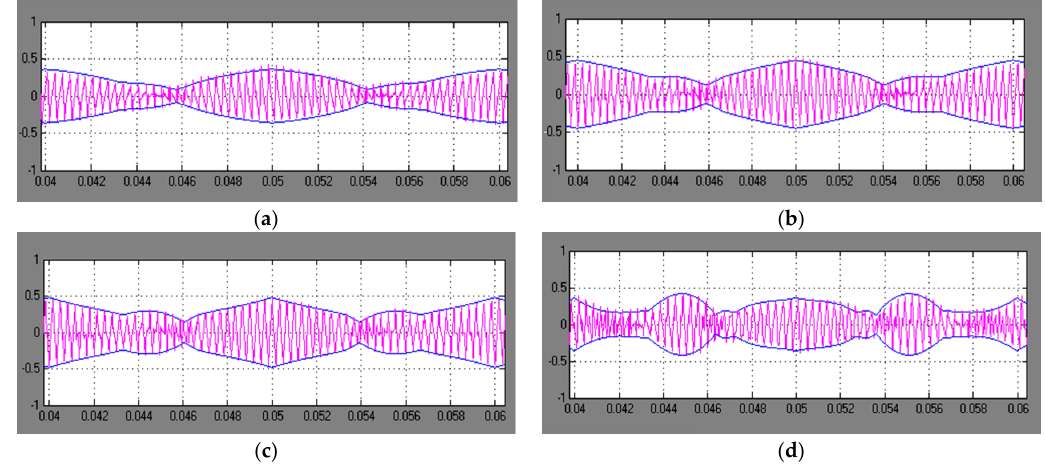
Figure 24. Experimental current ripple and theoretical envelope in the case of DPWM − for: ( a ) m = 1/6; ( b ) m = 1/4; ( c ) m = 1/3; and ( d ) m = 1/2.